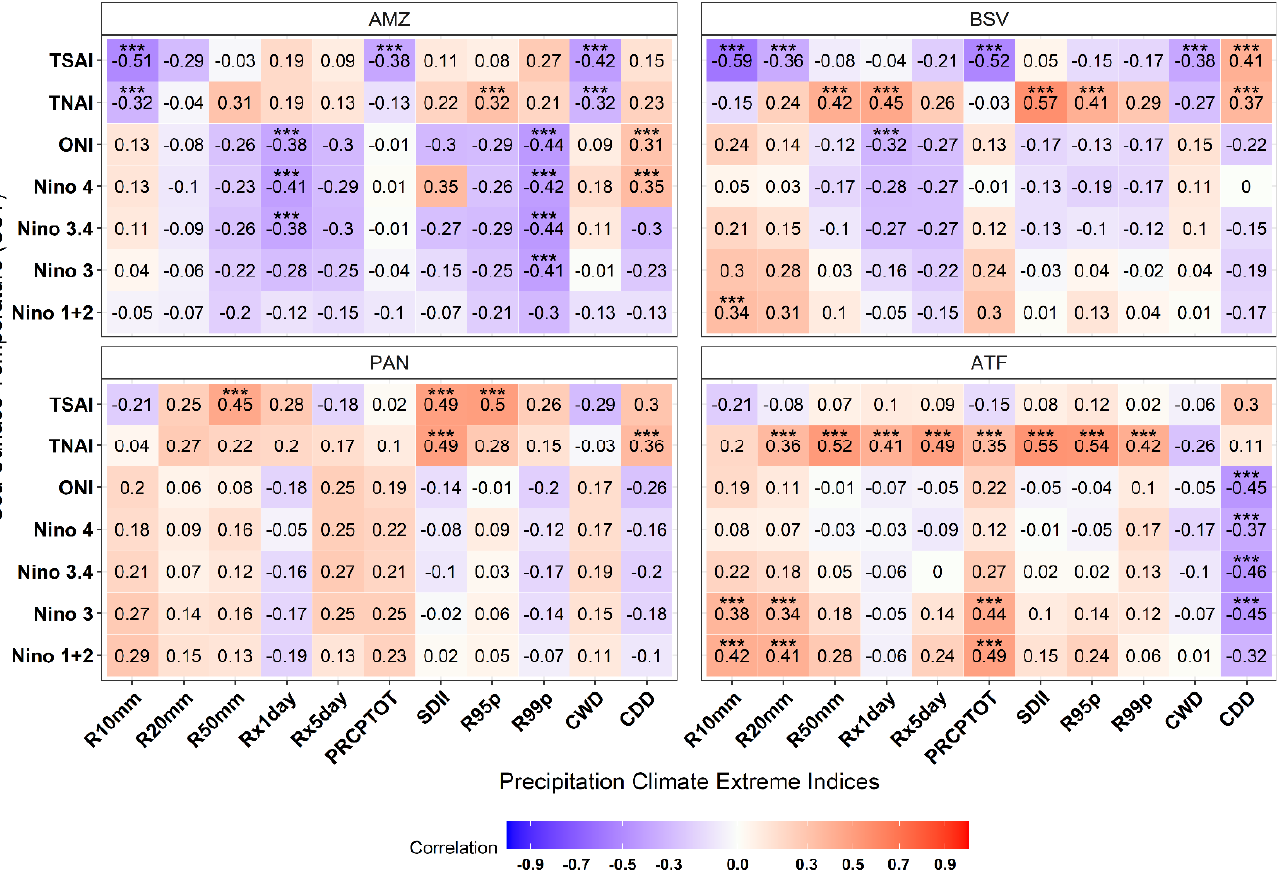
Figure 4. Pearson’s correlation coefficients of Sea Surface Temperature (SST) anomalies including TSAI, TNAI, ONI, Nino 1 + 2, 3, 3.4, and 4 with precipitation extreme indices in the Amazon (AMZ), Brazilian Savanna (BSV), Pantanal (PAN), and Atlantic Forest (ATF) in the Brazilian Midwest from 1979 to 2019. Cells with *** indicate p -value <